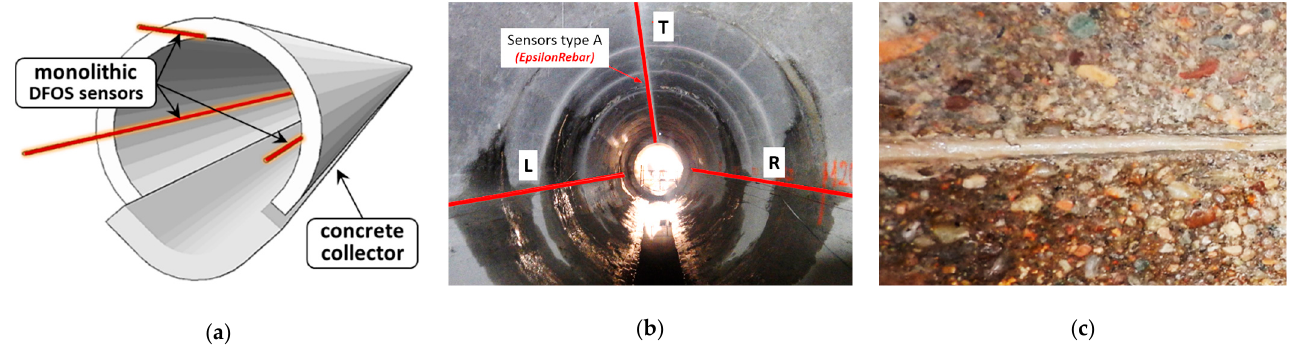
Figure 22. ( a ) Design of the collector with monolithic sensors; ( b ) the view of the collector with marked locations of monolithic sensors; ( c ) near-to-surface groove filled with injection.